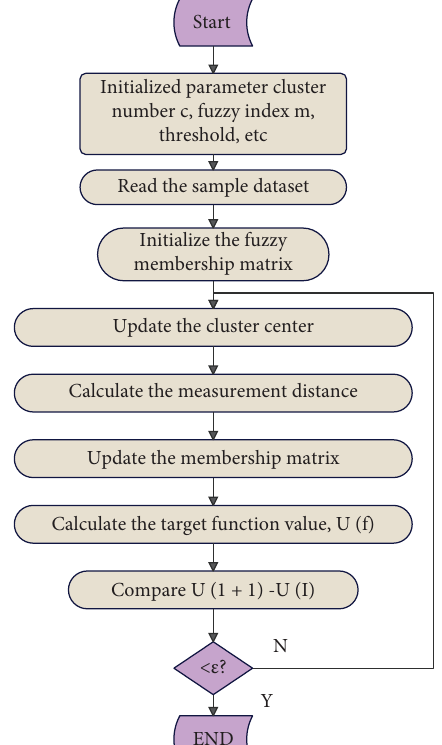
Figure 3: Flowchart of the GG algorithm.